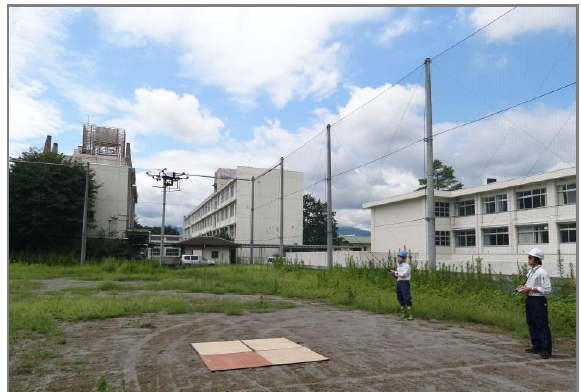
Figure 5. Flight conditions